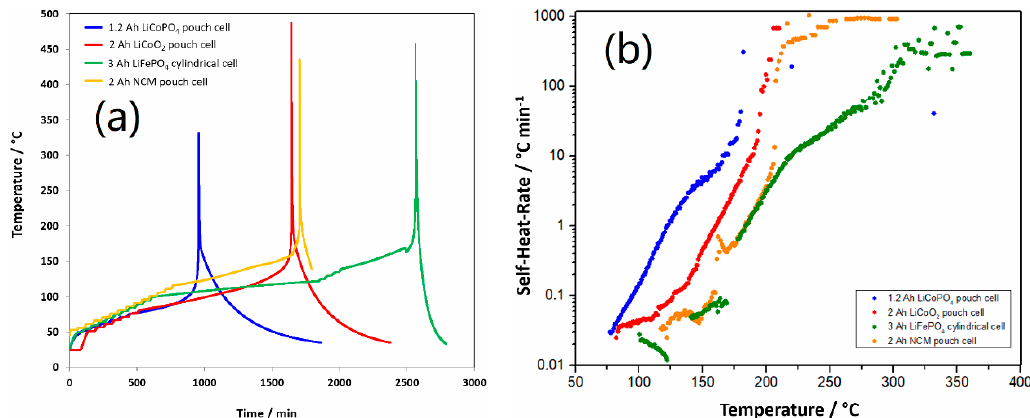
8 of 13 Figure 3. Evolution of the cell temperature and voltage with time during hot box test. The thermal runaway behavior of the 1.2 Ah graphite/LiFSI-Py 13 FSI/LCP pouch cell at 100% SOC was further investigated by ARC. For this, 2 Ah pouch cells employing the same anode but different cathodes (LiCoO 2 (LCO) and Li[Ni 0.6 Co 0.2 Mn 0.2 ]O 2 (NCM)), and a 3 Ah LFP cylindrical cell were compared. Before the test, the experimental cells were fully charged and cut off at 4.4 V for the LCO and NCM cells and at 3.65 V for the LFP cell. The preliminary test data obtained from the ARC heat- wait-search test are presented in Figure 4a and the corresponding self-heating rate (°C min − 1 ) vs. temperature plots are presented in Figure 4b. The onset, thermal runaway, and maximum temperatures are summarized in Table 2. The onset temperature is reached when the self-heating rate is greater than the detection limit of the accelerating rate calorimeter (0.02 °C min − 1 ). The first values of the self-heating rate associated with cell degradation are probably related to the start of SEI degradation [23]. The SEI film is composed of stable and metastable components such as Li 2 CO 3 and (CH 2 OCO 2 Li) 2 , depending on the composition of the carbonate-based electrolyte [24]. The onset temperature of the LCP cell (77 °C) is close to that of the LCO cell (82 °C) but lower than those of the